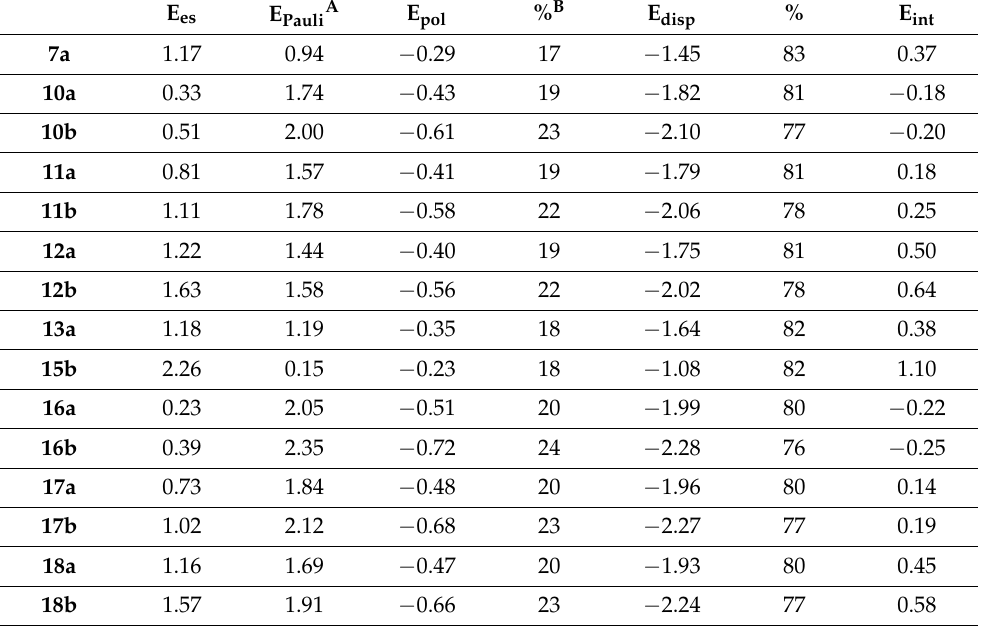
Table 8. LMOEDA/MP2/aug-cc-pVDZ decomposition of the interaction energy in vacuum of complexes into electrostatic (E es ), Pauli repulsion (E Pauli ), polarization (E pol ) and dispersion (E disp ) components. All quantities in kcal/mol.